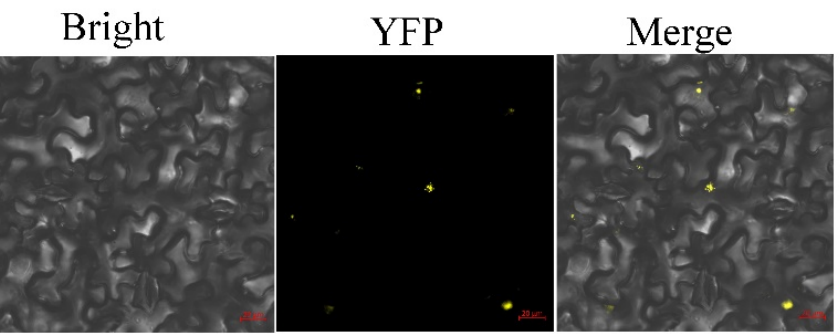
Figure 2. The subcellular location of SmTCP7a. SmTCP7a-YFP was detected using Nicotiana ben- thamiana leaves. Bar = 20 μ m.